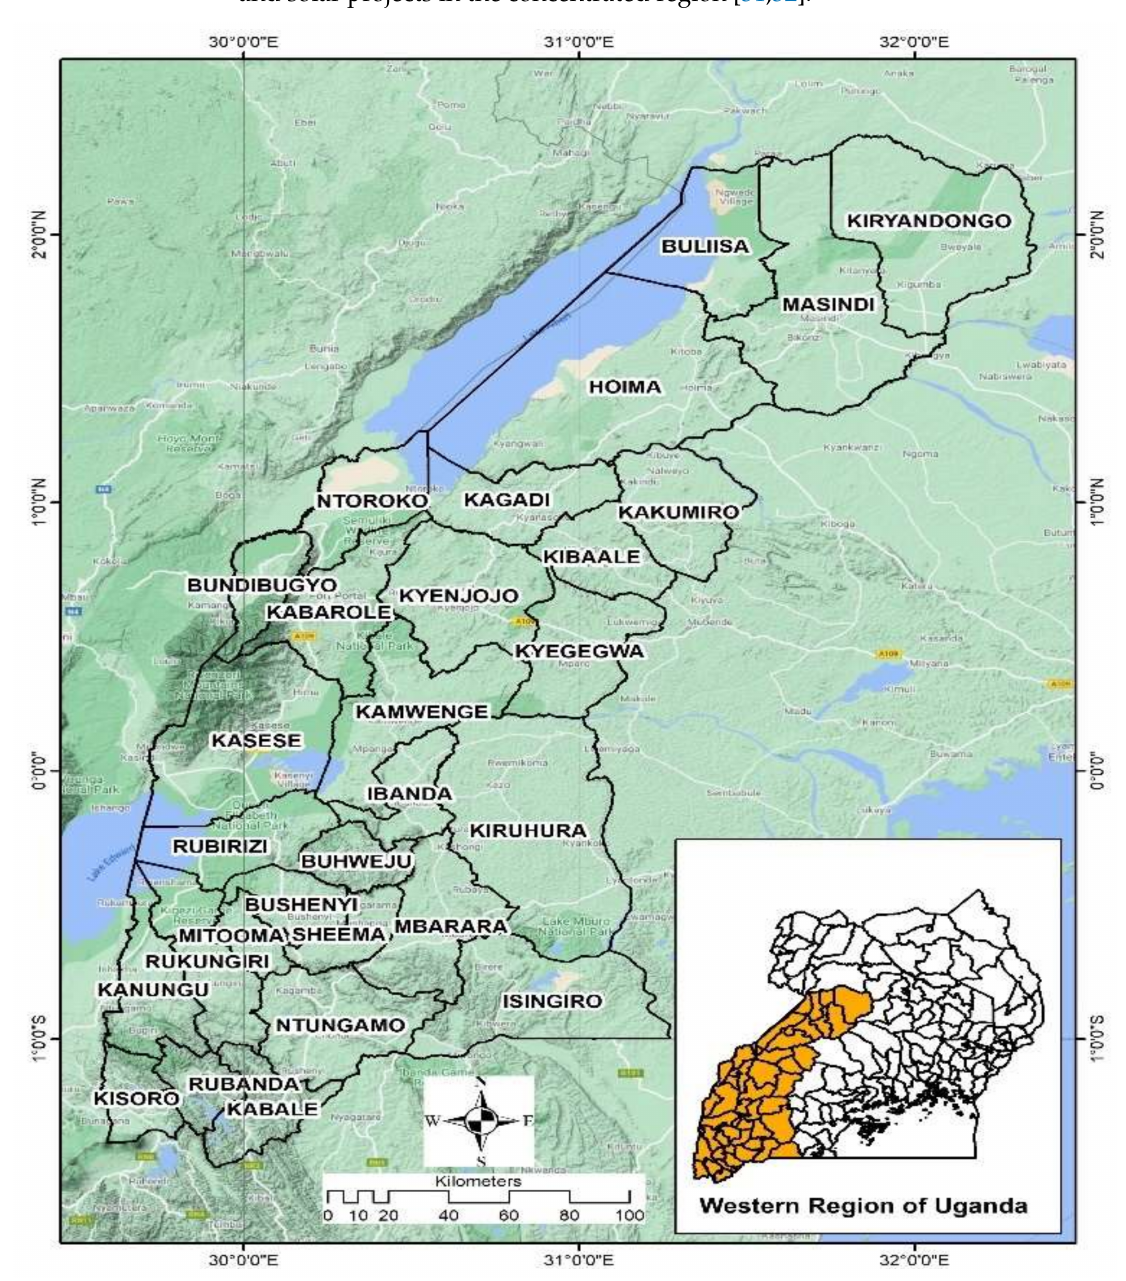
Figure 1. Map of study